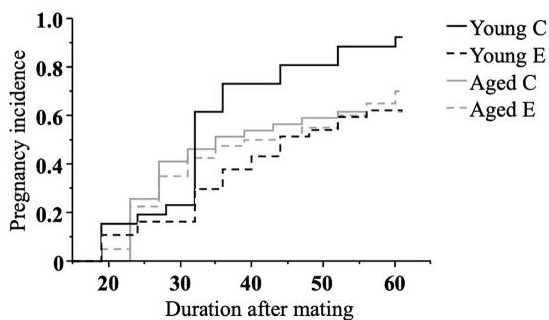
Figure 2. Kaplan–Meier survival graph showing pregnancy incidence. Mating was initiated on day 1 or day 43 and repeated every 4 days until day 42 or day 84 (Young study, Aged study, respectively). Mice that did not conceive by the last mating were considered infertile. Infertile mice were sacrificed at 900 am on day 60 or 102 (Young study, Aged study, respectively). Thus, the observation time was 60 days after the initiation of mating in both studies. The Young C group conceived significantly earlier (log-rank and generalized-Wilcoxon, p < 0.05) than the Young E group (Young C; n = 26, Young E; n = 34, Aged C; n = 40, Aged E; n =